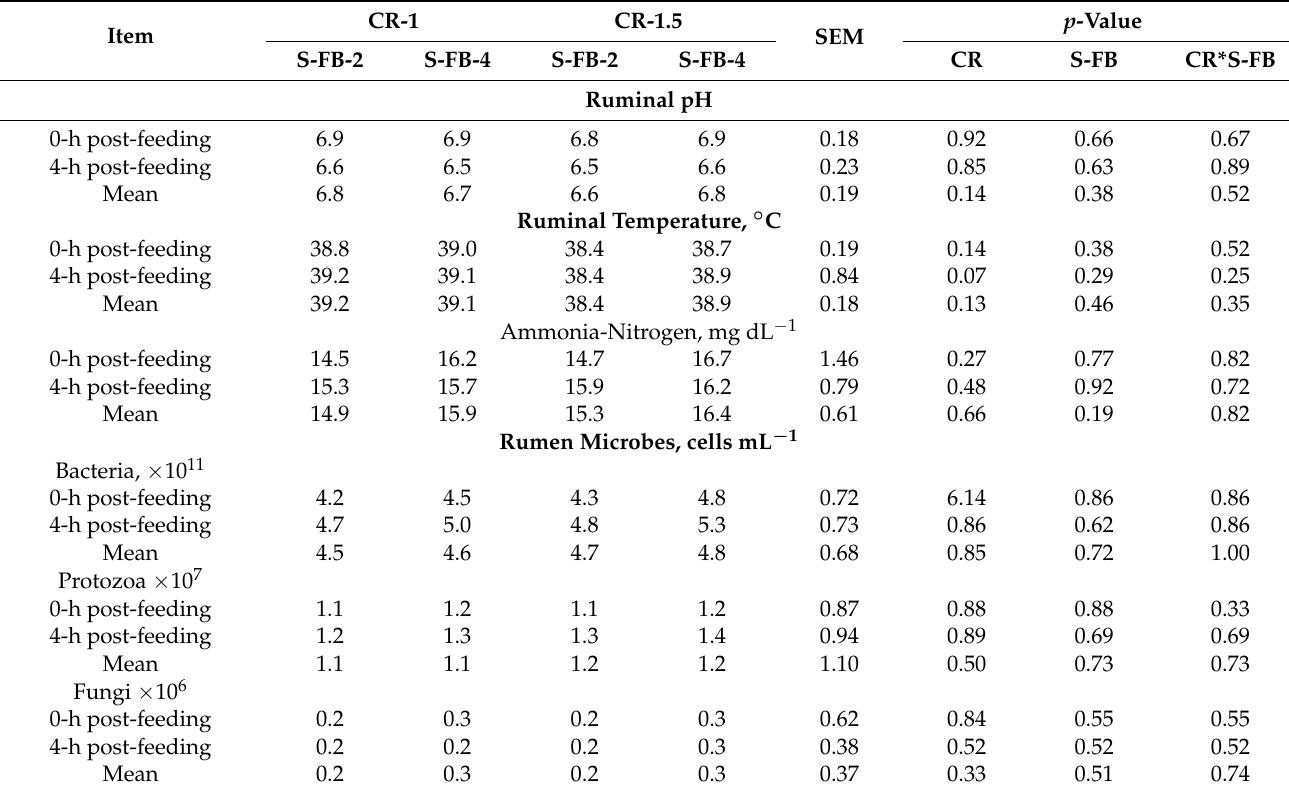
Table 3. Effect of fresh cassava root (CR) and a solid feed-block containing high sulfur (S-FB) on rumen ecology, microorgan- ism, and